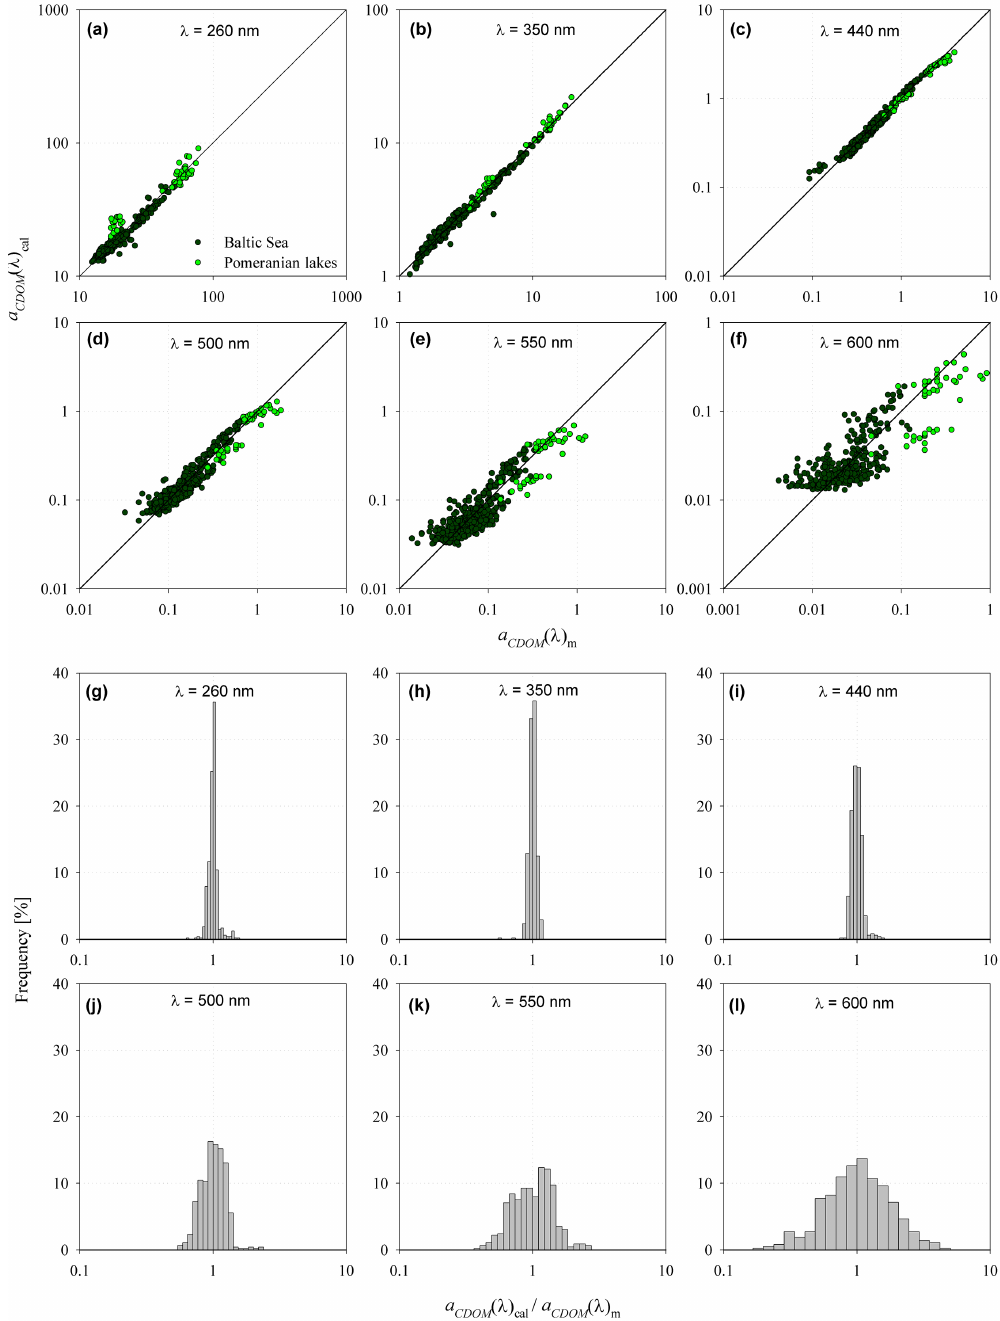
Figure 7. Comparison of light absorption coefficients measured ( a CDOM (λ) m ) and calculated ( a CDOM (λ) cal ) using model (Eq. 14) in the Baltic (black dots) and Pomeranian lakes (green dots) for selected wavelengths: (a) 260nm; (b) 350nm; (c) 440nm; (d) 500nm; (e) 550nm; (f) 600nm. The solid line represents the function a CDOM (λ) cal = a CDOM (λ) m . The probability density distribution of the ratio of calculated a CDOM (λ) cal to measured a CDOM (λ) m light absorption coefficients for selected wavelengths: (g) 260nm; (h) 350nm; (i) 440nm; (j) 500nm; (k) 550nm; (l)